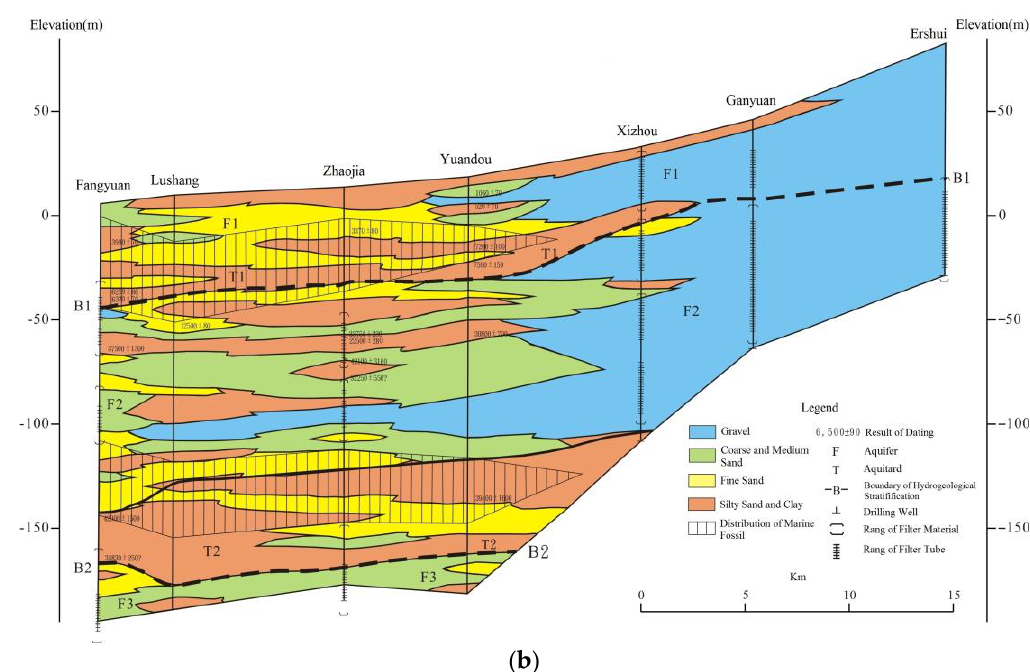
Figure 2. Conceptual hydrogeological map and cross-section of the study area. ( a ) The spatial distribution of the sediments. ( b ) The cross section of the line A-A’ of Figure 2a in the study area.